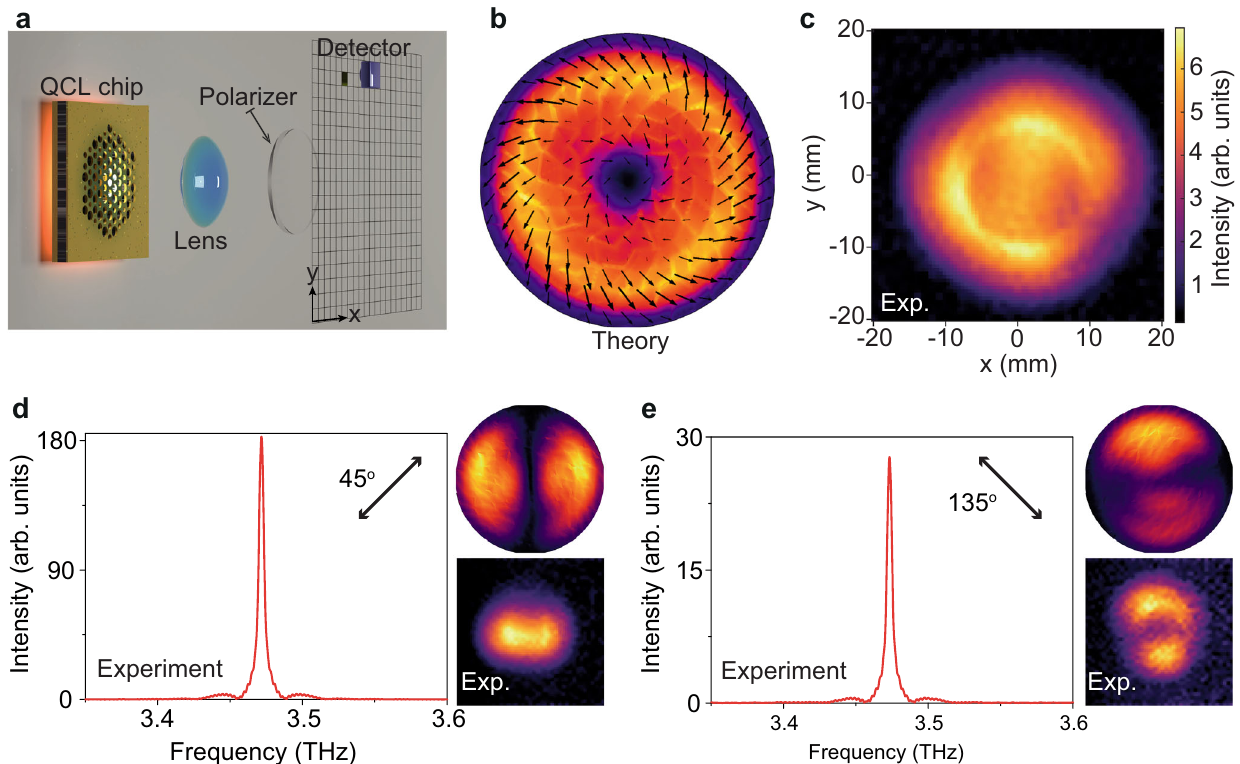
d , e Results obtained by inserting a wire-grid polarizer between the focal lens and THz detector, with polarization angles of 45° and 135° respectively. Left panels: polarization-resolved emission spectra. Right panels: numerically calculated (upper) and experimentally measured (lower) intensity